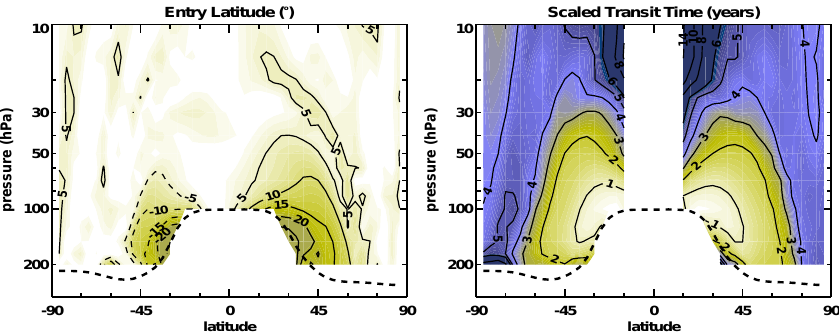
Fig. 5. Annual mean stratospheric entry latitude (left, in degrees, southern latitudes dashed, zero contour omitted) and scaled transit time (right, in years) of residual circulation trajectories from CMAM. The scaling used on the right is given by 90 ◦ / | ϕ a − ϕ e | , where a and e refer to arrival and entry latitudes, respectively. In the tropics, ϕ a ≈ ϕ e , which results in exceedingly large values – the region equatorward of 15 ◦ is therefore omitted on the right. Thick dashed lines mark average position of the tropopause.